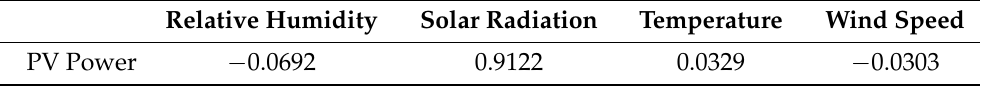
Table 1. Values of Pearson coefficient between output variables and each on the input